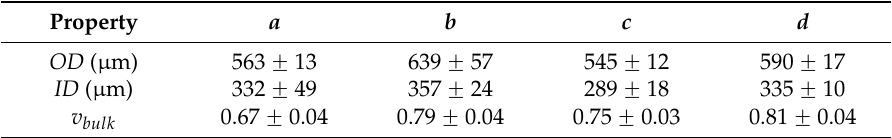
Figure 1. SEM images of the cross section (top) and outer surface (bottom) of the four hollow fiber membrane supports: ( a ) low porosity Matrimid ® ; ( b ) high porosity Matrimid ® ; ( c ) low porosity Torlon ® ; ( d ) high porosity Torlon® . Table 2. Dimensions and porosity of the hollow fibers.